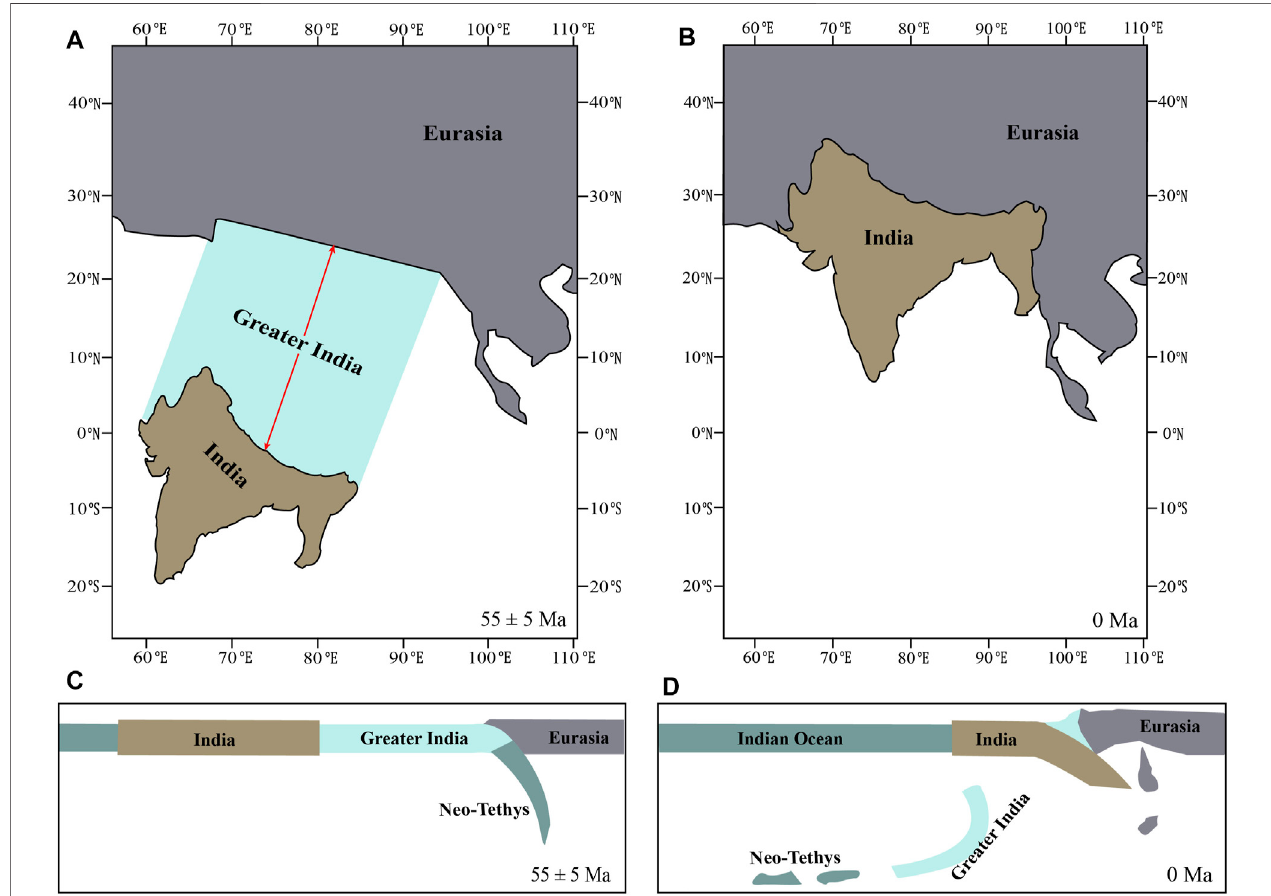
FIGURE 1 | Tectonic background and corresponding pro fi les of the Indo-Eurasian system at the initial collision (A , C) and present-day Tibetan plateau (B , D) (Yi et al., 2011; Ingalls et al., 2016; Wang et al., 2019; van Hinsbergen et al., 2019; Meng et al., 2019, 2020; Parsons et al., 2020).